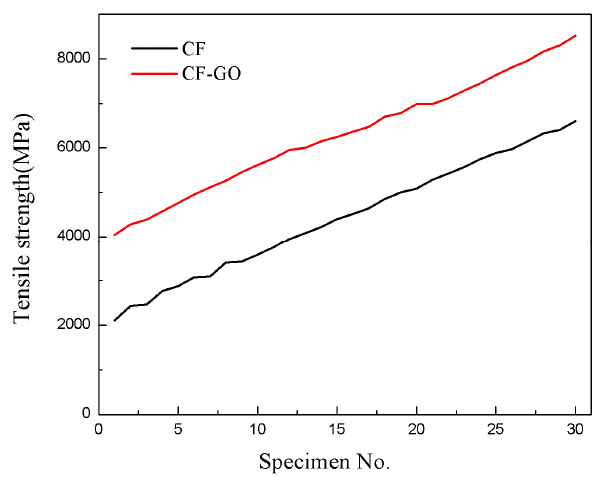
Figure 6. Tensile strength test curve of the CF and CF–GO.